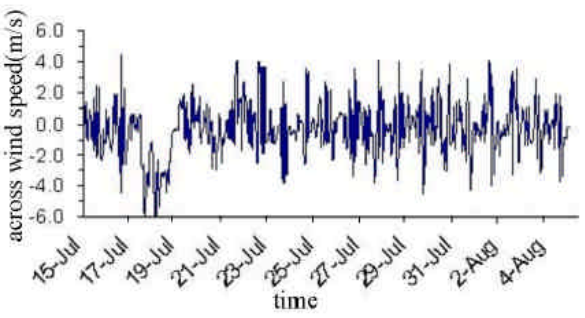
Figure3. Hourly time series of wind speed (U 10 ) against time (24h interval)